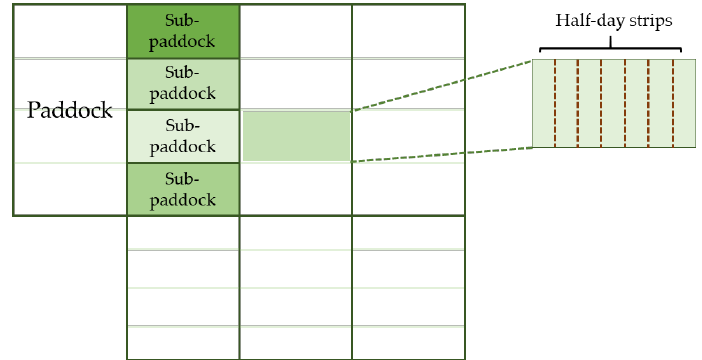
Figure 1. Schematic representation of the experimental area: seven paddocks, with each divided into four sub-paddocks. Each sub-paddock was divided into half-day strips. Four 11-cows herds were randomly allocated to the sub-paddocks to graze simultaneously within the same paddock.